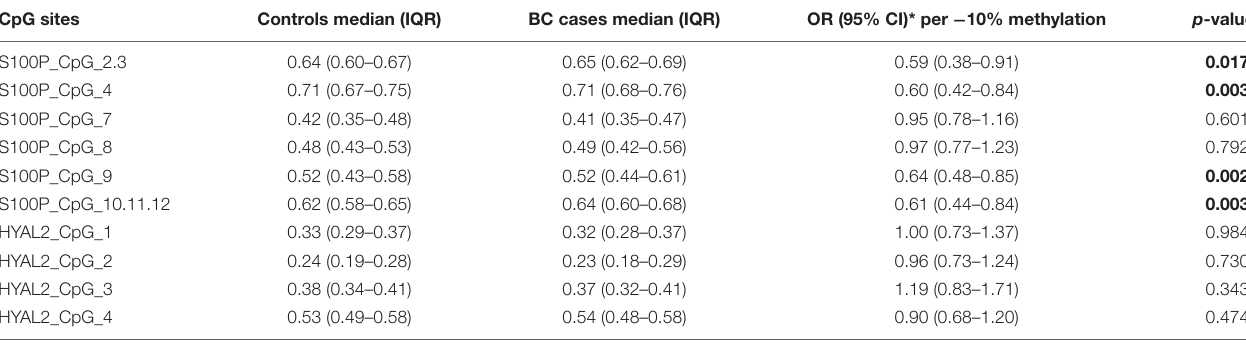
FIGURE 1 | Methylation levels of CpG sites in S100 calcium-binding protein P gene ( S100P ) and hyaluronoglucosaminidase 2 gene ( HYAL2 ) in sporadic breast cancer (BC) cases and controls in Study I measured by MassARRAY. (A) Box plot shows the distribution of methylation levels of all nine measured CpG sites in S100P . (B) Box plot shows the distribution of methylation levels of all four measured CpG sites in HYAL2 . The p -values were calculated by logistic regression adjusted for age and batches of measurement; # p > 0.05, * p ≤ 0.05, ** p ≤ 0.01, *** p ≤ 0.001. TABLE 1 | Methylation differences of S100P and HYAL2 between BC cases and controls in Study I. CpG sites